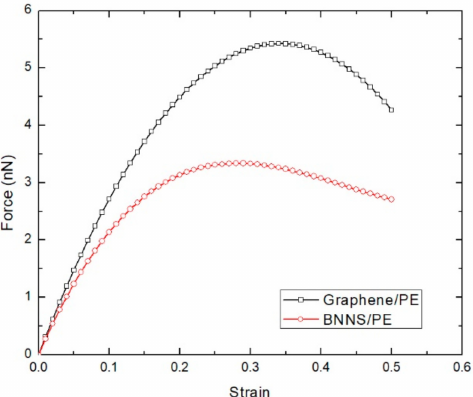
Figure 3. Force–strain plot of the graphene / PE and boron nitride nanosheet / PE nanocomposites at 300 K.